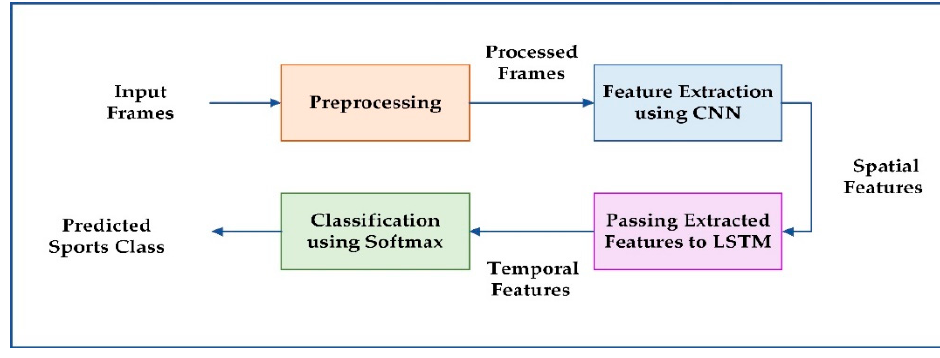
Figure 1. Workflow of the proposed TBSV classification approach.